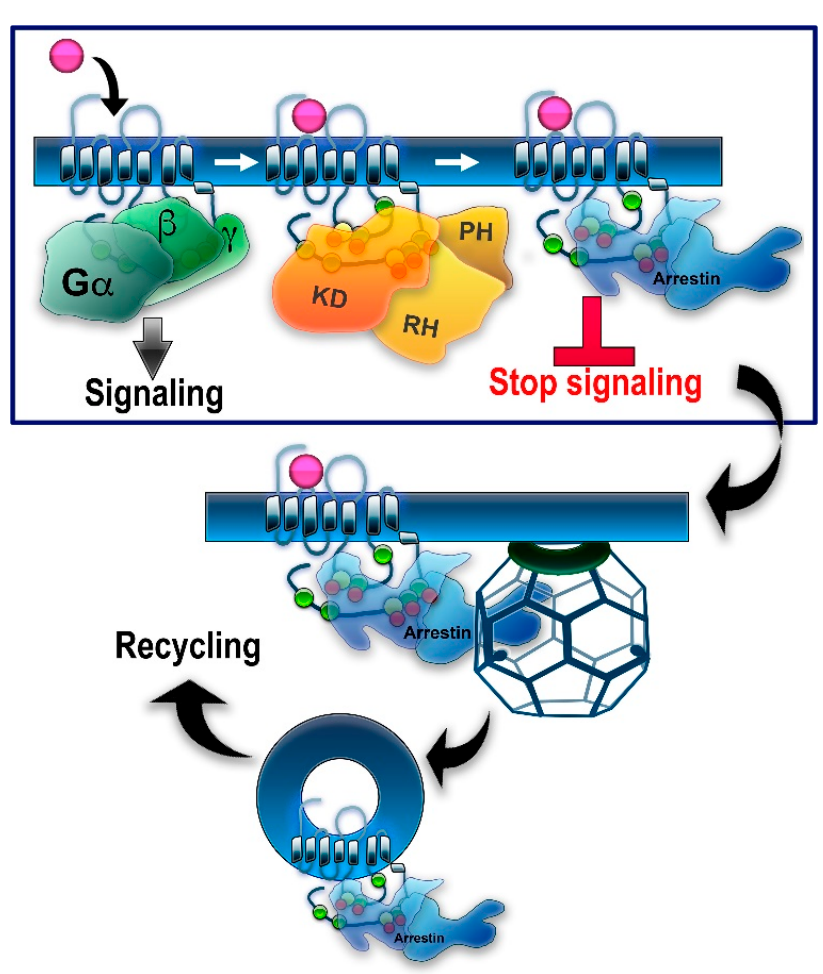
Figure 1. GRK/arrestin-mediated homologous desensitization of GPCRs. The classical paradigm of homologous GPCR desensitization posits that active receptors are phosphorylated by one or more GRKs, whereupon arrestins selectively bind to active phosphorylated receptors. Relevant phosphorylation sites in different GPCRs are localized in the C-terminus, 3rd cytoplasmic loop, and/or other cytoplasmic elements of the receptor (see Figure 2). Putative phosphorylation sites are shown here as circles: serines—green; threonines—yellow. Bound arrestin shields the cytoplasmic part of the receptor, precluding further G protein activation—this constitutes receptor desensitization (boxed). Arrestin binding to a GPCR induces the release of the arrestin C-tail. C-tails of non-visual arrestin-2 and -3 carry binding sites for the main components of the internalization machinery of the coated pit, clathrin, and clathrin adaptor AP2 (clathrin cage is shown). Arrestin binding promotes GPCR internalization via clathrin coated pits followed by receptor resensitization/recycling or degradation/downregulation. Note that all GRKs have a kinase domain (KD) and an RGS homology domain (RH), but only GRK2/3 have a pleckstrin homology domain (PH) that binds G βγ , whereas other GRKs use different mechanisms of membrane localization.